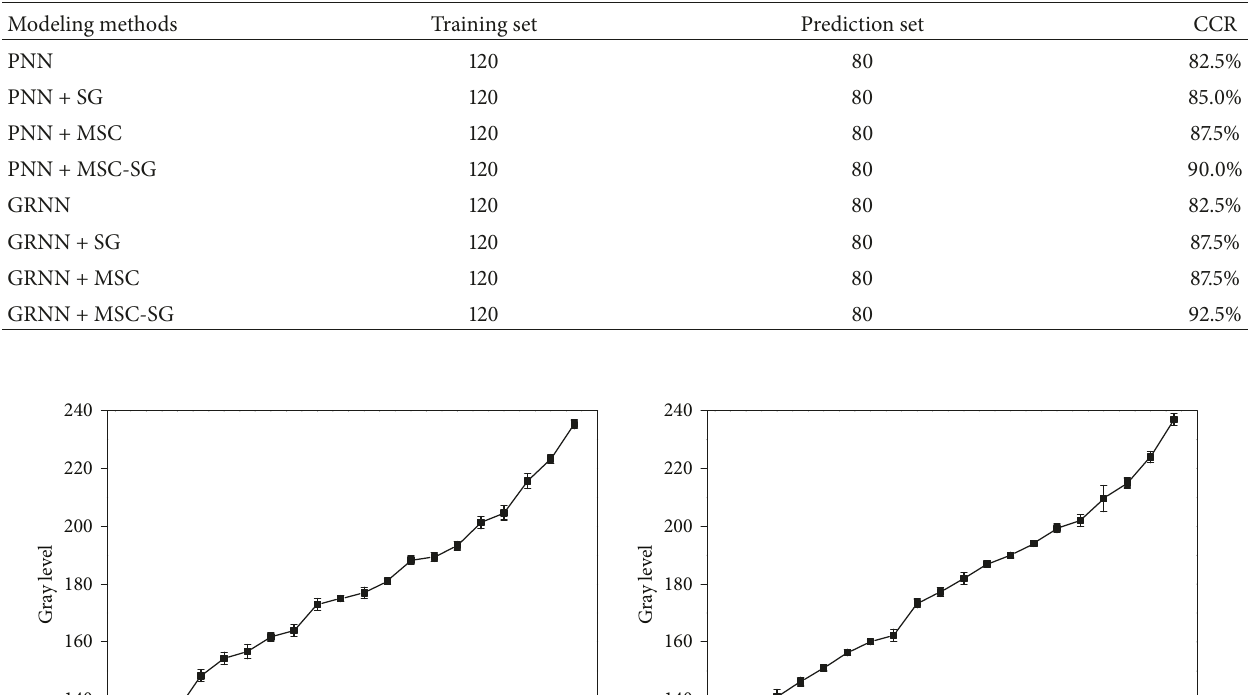
Table 1: Performance of PNN and GRNN with different preprocessing methods.